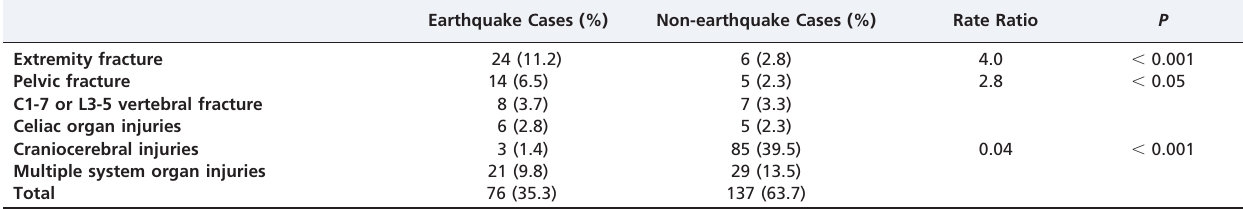
Table 2 - Coexisting Non-thoracic Damages in the Earthquake-related and Non-earthquake Cohorts. Earthquake Cases